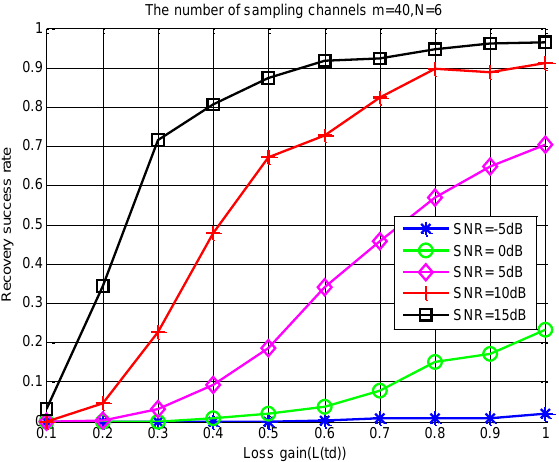
Figure 7. Influence of loss gain on recovery accuracy under different SNR levels. Sensors 2018 , 18 , x FOR PEER REVIEW